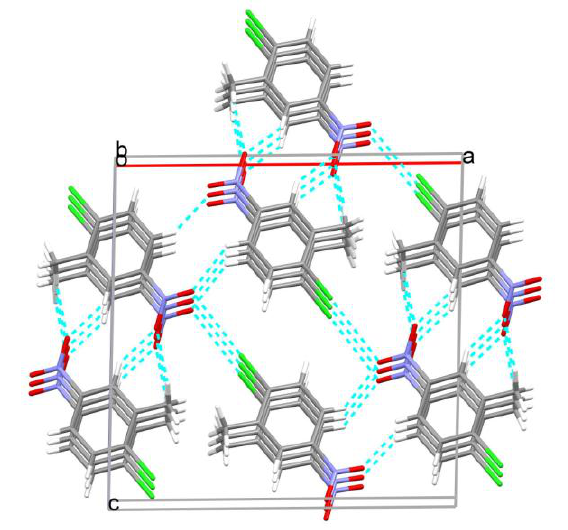
Figure 6. Overall crystal packing for 3 showing layers of molecules stacked along the b axis